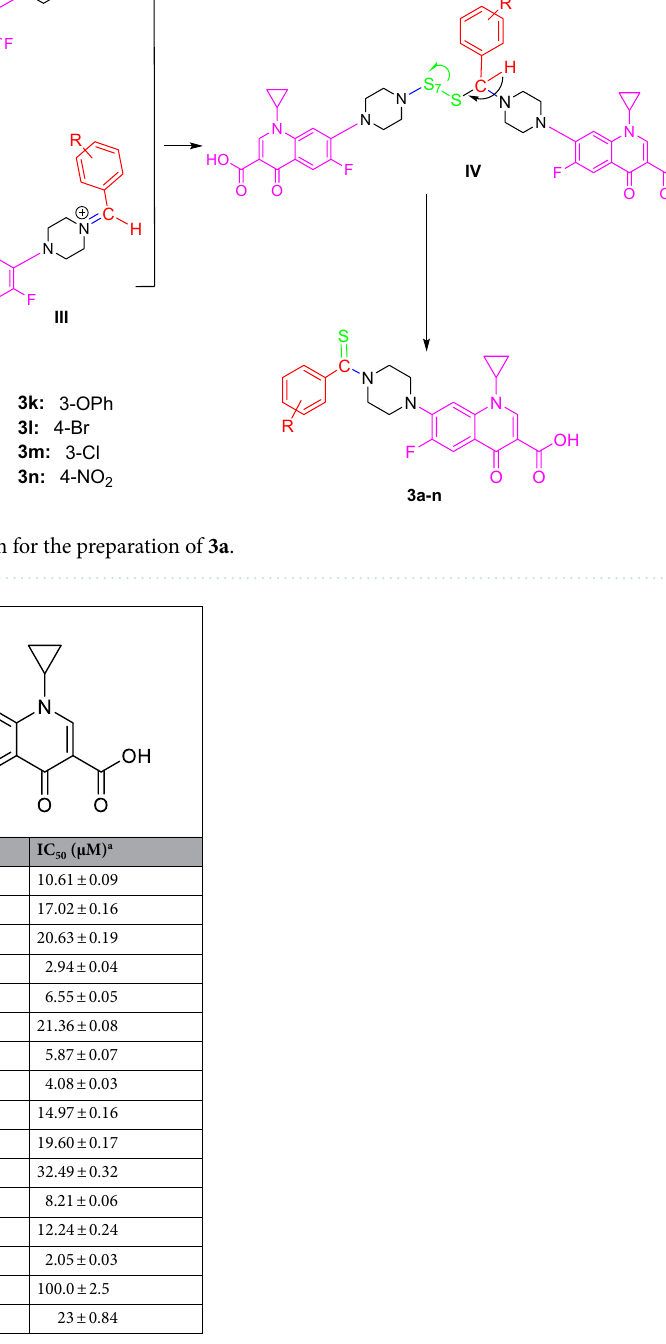
Table 1. The urease inhibitory activity of the synthesized compounds 3a–n . a Values are the mean ± SEM. All experiments were performed at least three